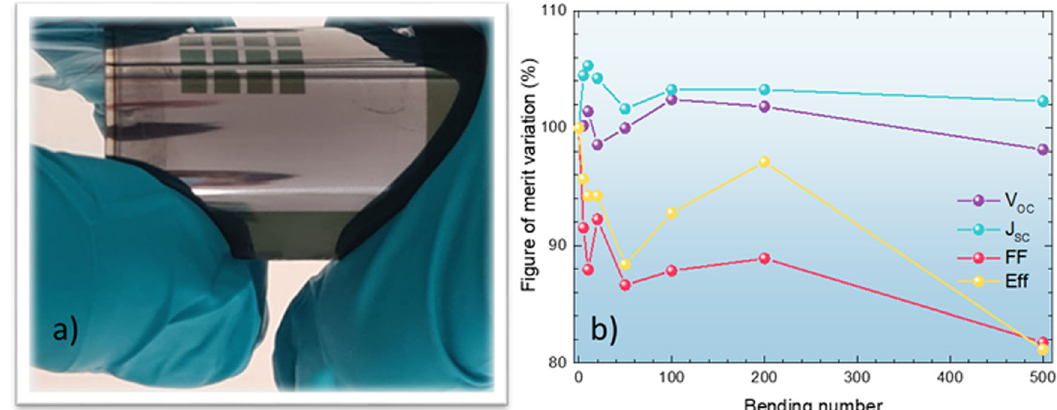
Fig. 6 Mechanical bending of the fl exible device. a Photography of the bent Flexible device; b Flexible fi gures of merit variation as a function of the bending